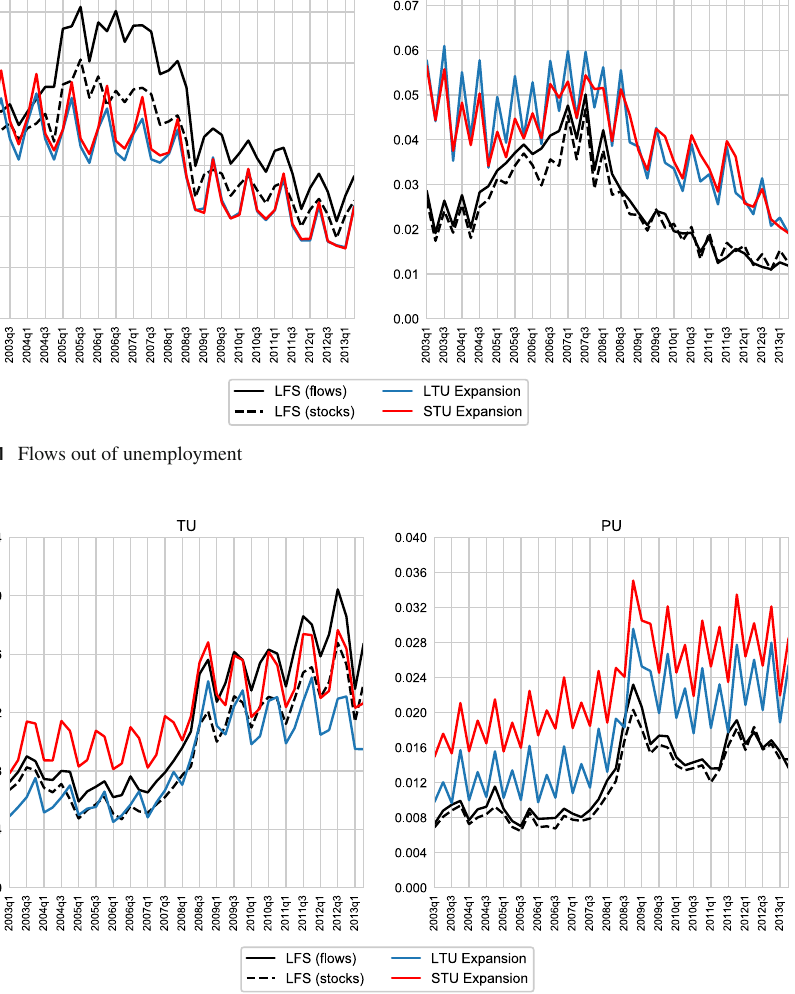
Fig. 22 Flows into unemployment. Source : MCVL and the